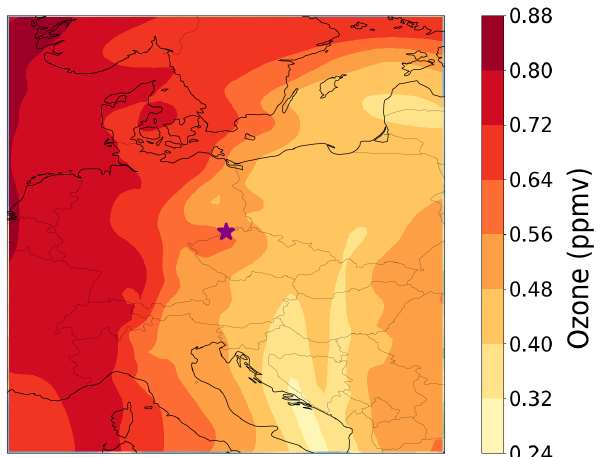
Figure 6. Horizontal map of ERA5 ozone mixing ratio at a pres- sure level of 148hPa on 11 June 2019 at 01:00UTC (case 1). The measurement site is indicated by a purple